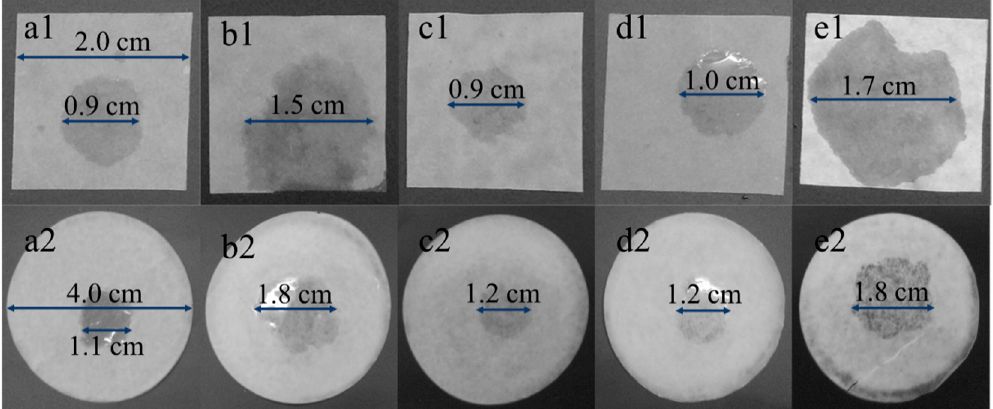
Figure 3. The wetted area of an electrolyte for membranes before and after the homogenization: ( a1 , a2 ) bamboo pulp; ( b1 , b2 ) hardwood pulp; ( c1 , c2 ) softwood pulp; ( d1 , d2 ) cotton pulp; ( e1 , e2 ) hemp pulp.